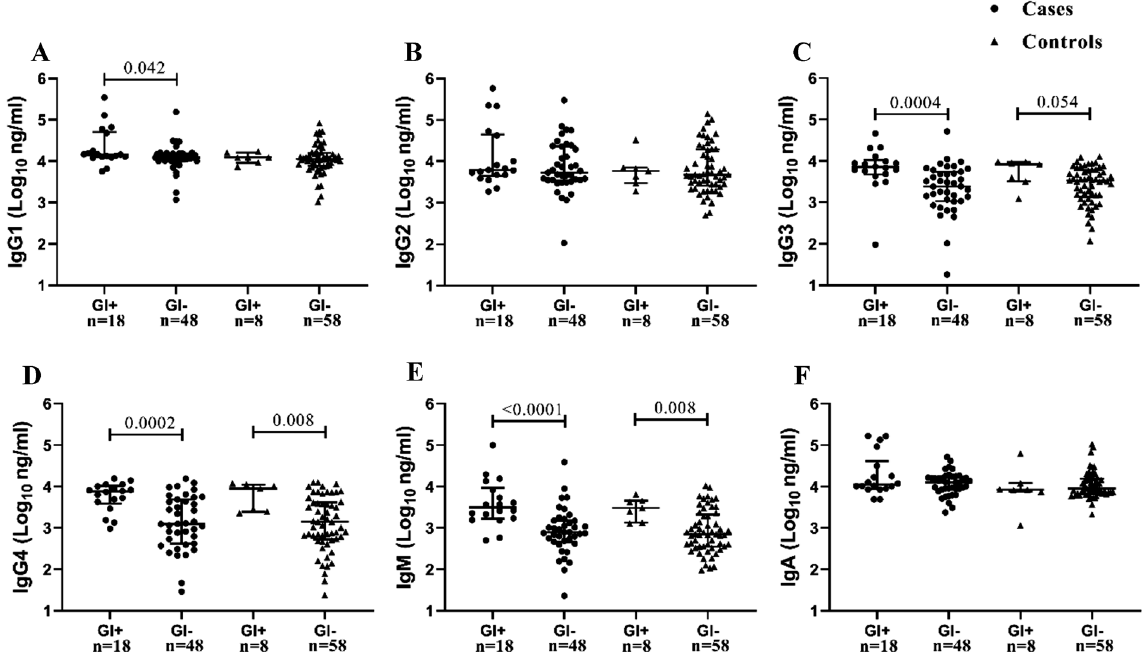
Figure 2. Comparison of mucosal IgG subclasses and isotypes in women stratified for presence of genital inflammation (GI+) or absence of genital inflammation (GI−) within cases [GI+ (n = 18) and GI− (n = 48)] and controls [GI+ (n = 8) and GI− (n = 58)] pre-HIV infection. Each data point represents an individual sample, the line-bars represents medians and interquartile ranges. Mann–Whitney U test and unpaired t -tests were used to compare between groups and p < 0.05 were considered statistically significant. Black circle represents cases and black triangle represents